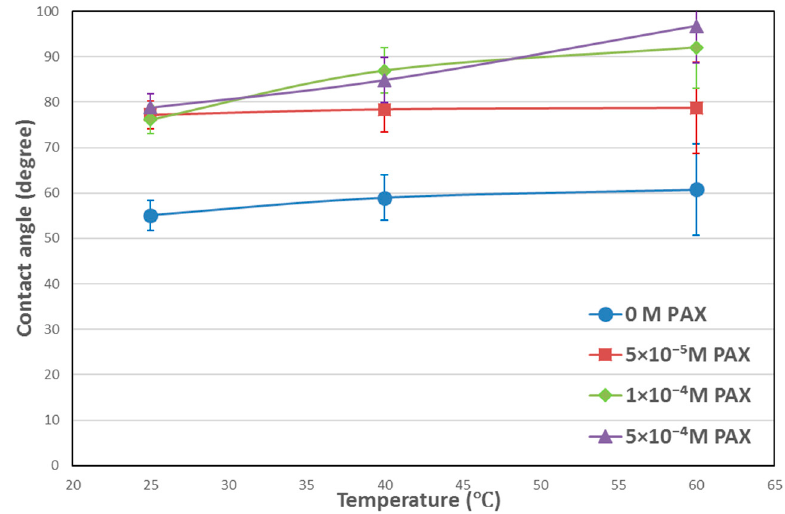
Figure 2. Contact angle results of chalcopyrite surface after contacting with PAX solution of different concentrations for 5 mins at 25 °C, 40 °C, and 60 °C.